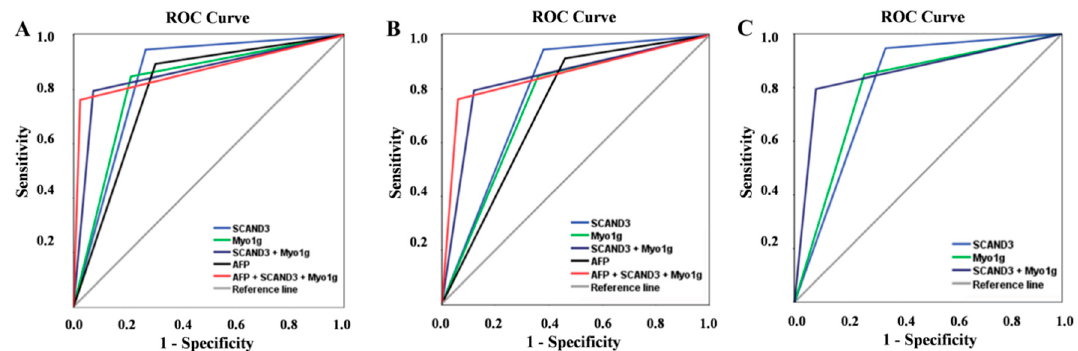
Figure 5. Diagnostic values of serum gene methylation makers and AFP for HCC patients. The receiver operating characteristic (ROC) of SCAND3, Myo1g, SCAND3 + Myo1g, AFP, and AFP + SCAND3 + Myo1g for HCC diagnosis in the whole HCC cohort ( A ), early-stage HCC patients ( B ), and AFP-negative HCC patients ( C ).